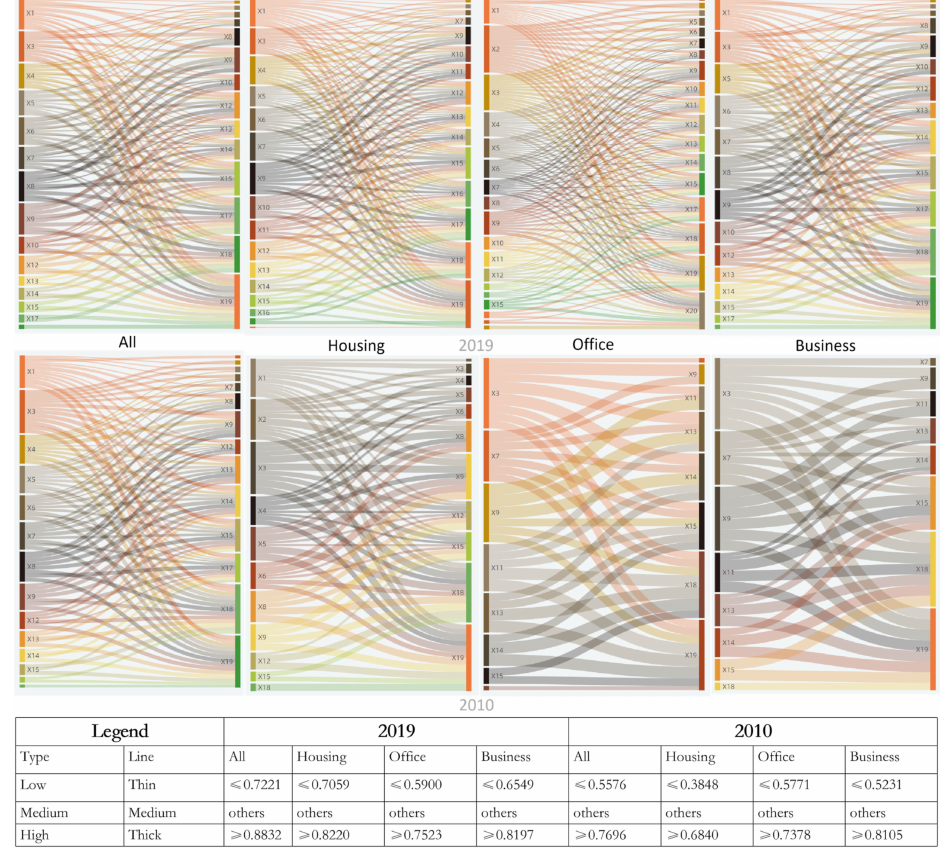
Figure 10. Analysis of interaction detector. Table 4. Statistical analysis of factor pairs and interaction